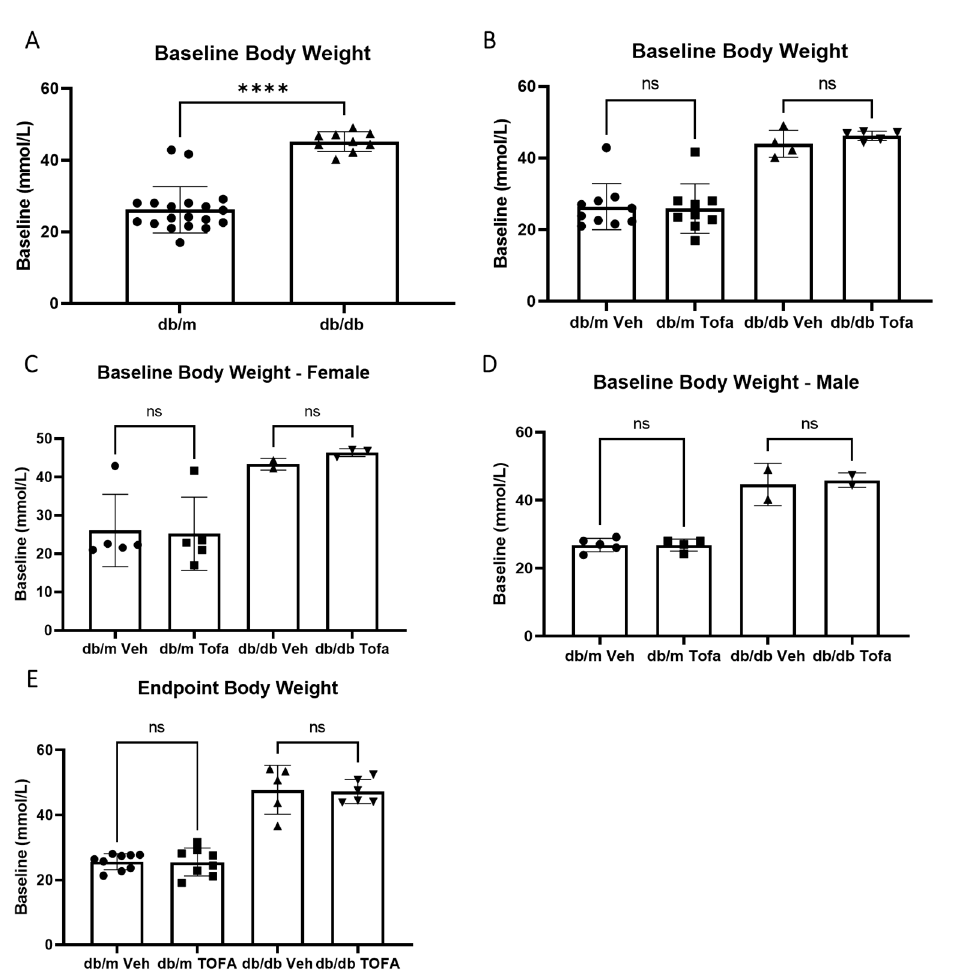
Figure 5. Tofacitinib citrate does not alter body weight in db/db or db/m mice. Blood weight measurements were taken from all mice daily throughout the study. ( A ) Baseline body weight in db/db and db/m mice at 2.5 months of age. **** p < 0.0001, Mann Whitney test. ( B ) Body weight in different groups of db/m and db/db mice before tofacitinib citrate or vehicle treatment. ( C , D ) Body weight in female ( C ) and male ( D ) of different groups of db/m and db/db mice before tofacitinib citrate (Tofa) or vehicle (Veh) treatment. ( E ) Endpoint body weight in tofacitinib citrate or vehicle treated db/db and db/m mice. Mean ± SD, ns = not significant difference, Kruskall-Wallis test.